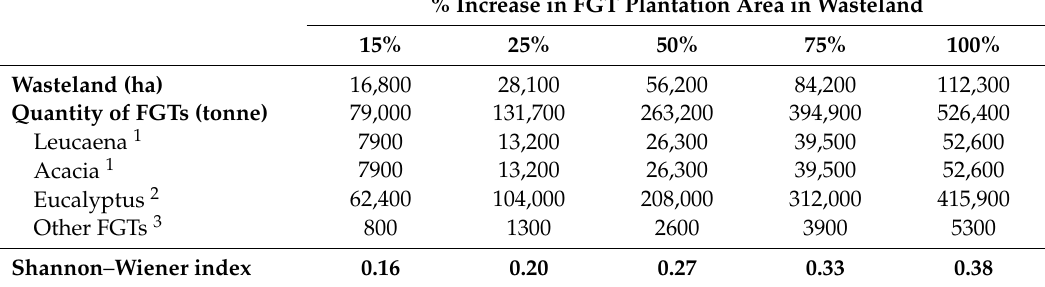
Table 9. Shannon–Wiener index forecast and increase in the fast-growing tree plantation area in the